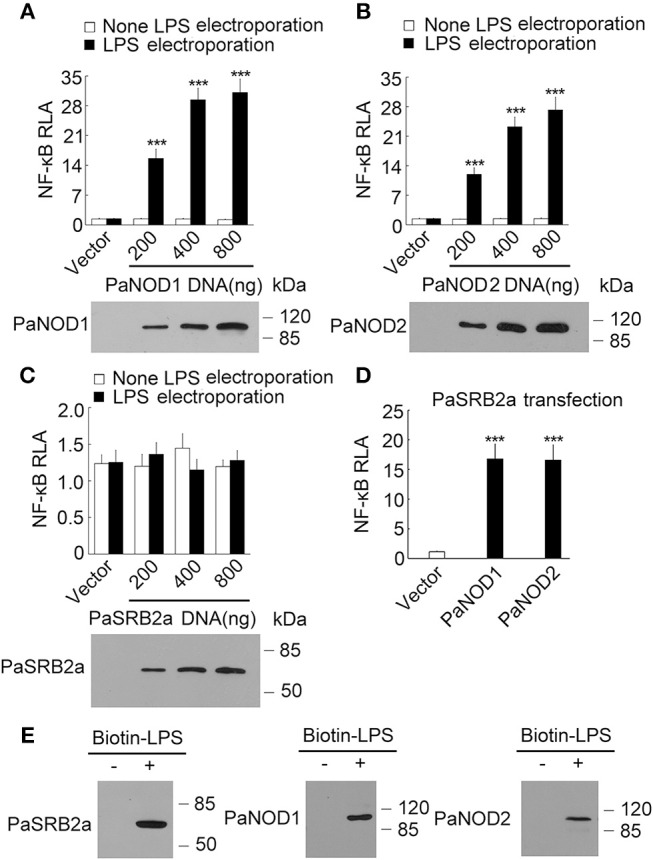
LPS activated NF-κB via PaNOD1, PaNOD2, and PaSRB2a. (A) PaNOD1 effect on NF-κB activation in LPS-treated HEK293T cells. (B) PaNOD2 effect on NF-κB activation in LPS-treated HEK293T cells. (C) PaSRB2a effect on NF-κB activation in LPS-treated HEK293T cells. (D) The effect of PaNOD1 and PaNOD2 in HEK293T cells with PaSRB2a transfection after LPS treatment. Bottom panels present western blots of cell lysates to monitor protein expression. (E) Physical interaction between LPS and PaSRB2a, PaNOD1, PaNOD2. Each lane represents the cell lysate incubated with biotinylated LPS (Biotin-LPS) and avidin beads. Each bar represents the mean ± SE. Representative blots of three independent experiments are shown. n = 5. Data are representative of two (A–D) and three (E) independent experiments. ***P < 0.001.